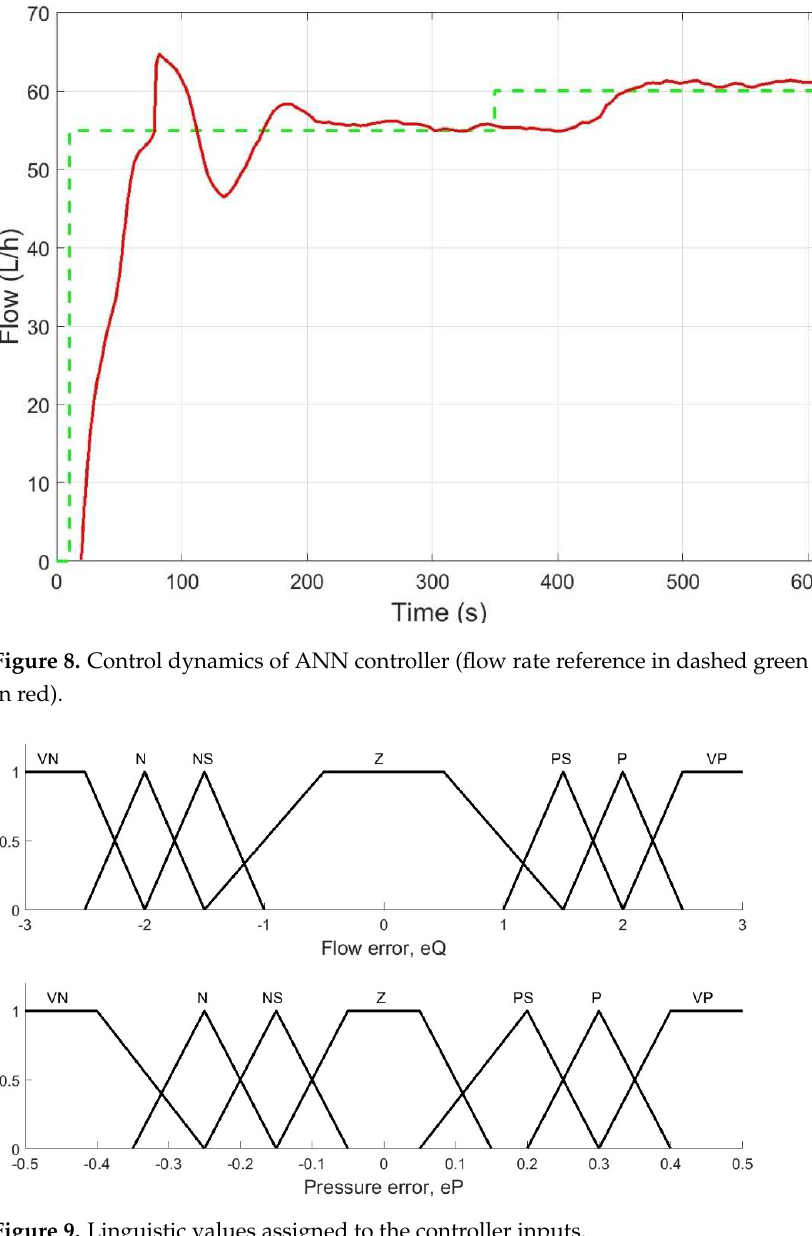
Figure 7. Operating working area of the pilot plant obtained for pump signal speed 0.5–3 V (108– 650 rpm) and valve opening 65–80%.